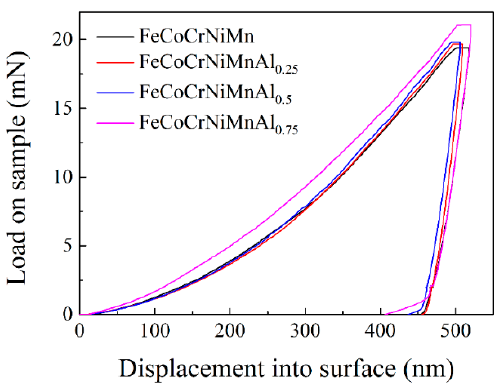
Figure 4. Load-displacement curves of the FeCoCrNiMnAl x cladding layers after the nano-indentation test.